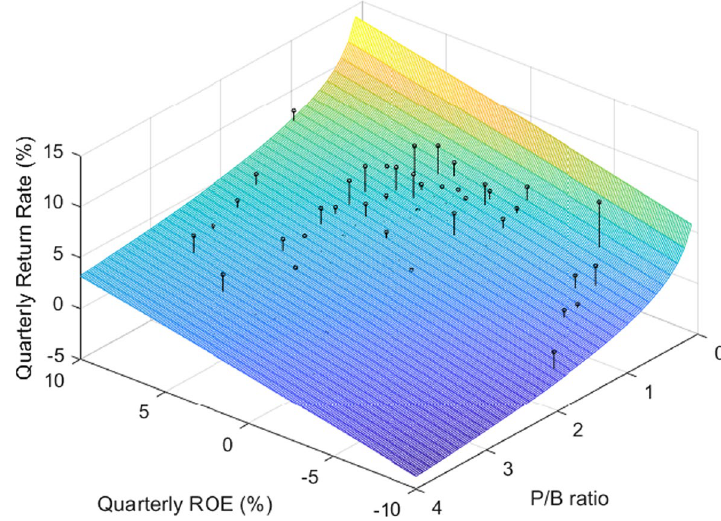
Fig. 37 3D scatter diagram of ROE (X), P/B (Y) in the t quarter, and the return rate in the t (circle: actual values, another end: predicted values):